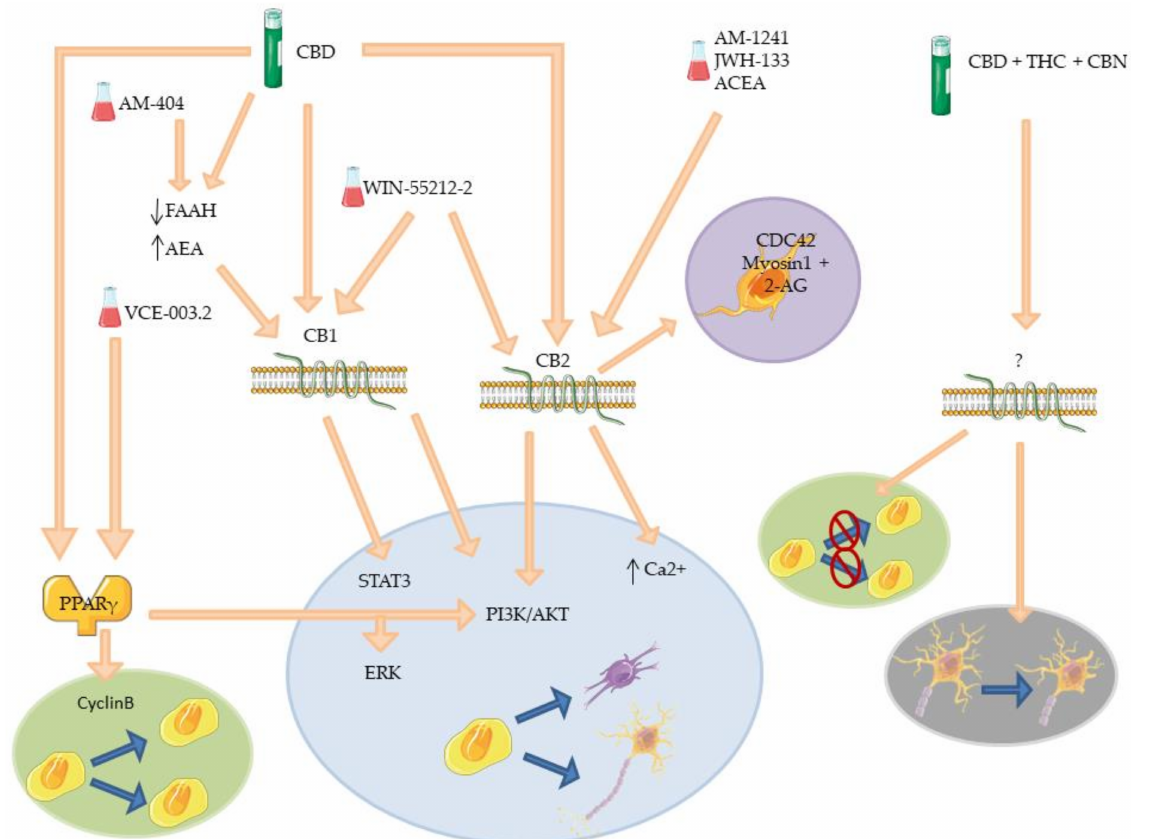
Figure 5. Mechanisms of phyto- and synthetic cannabinoids on neurogenesis in pathological models. The picture offers a schematic representation of the receptors involved in neurogenesis and their signal cascade activated after agonist action of phyto- or synthetic cannabinoids in the mentioned disease models. 2-AG: 2-arachidonoyl glycerol; AEA: arachidonyol ethanolammide or anandamide; CB1: cannabinoid receptor 1; CB2: cannabinoid receptor 2; CBD: cannabidiol; CBN: cannabinol; CDC42: cell division cycle 42; ERK: extracellular signal-regulated kinases; FAAH: fatty acid amide hydrolase; PI3K/AKT: phosphoinositide 3-kinases/protein kinase B; PPAR γ : peroxisome proliferator- activated receptor gamma; STAT3: signal transducer and activator of transcription 3; THC: ∆ 9